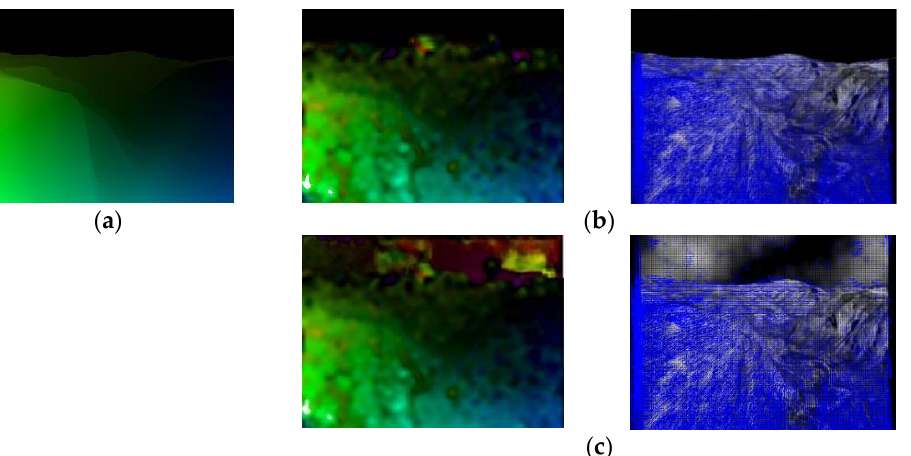
Figure 5. Real flow and estimated flow on synthetic images of Yosemite. ( a ) Real flow. ( b ) Our ap- proach for optical flow estimation on synthetic images of Yosemite without clouds. ( c ) Our approach for optical flow estimation on synthetic images of Yosemite with clouds.